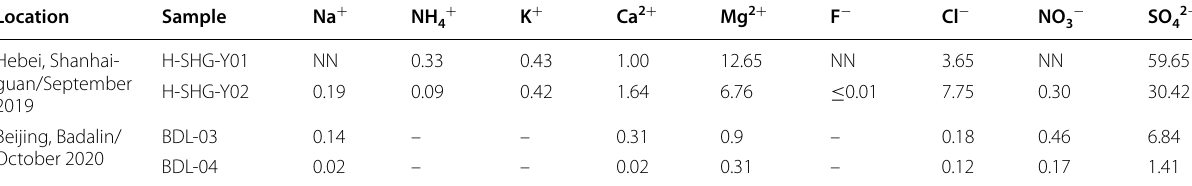
NN not detectable,